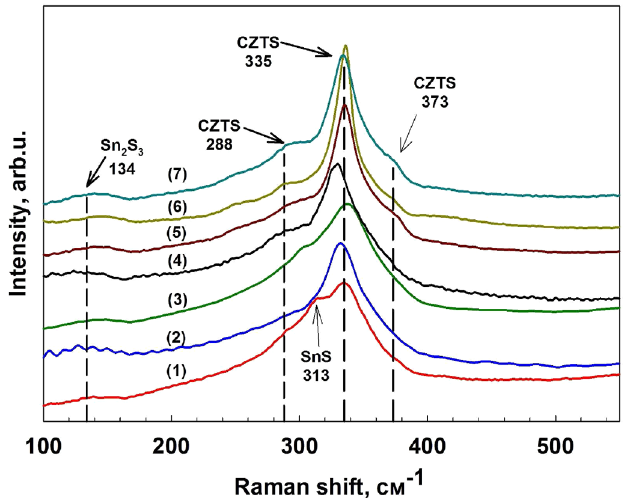
Fig. 3. The Raman data of the CZTS thin fi lms on glass